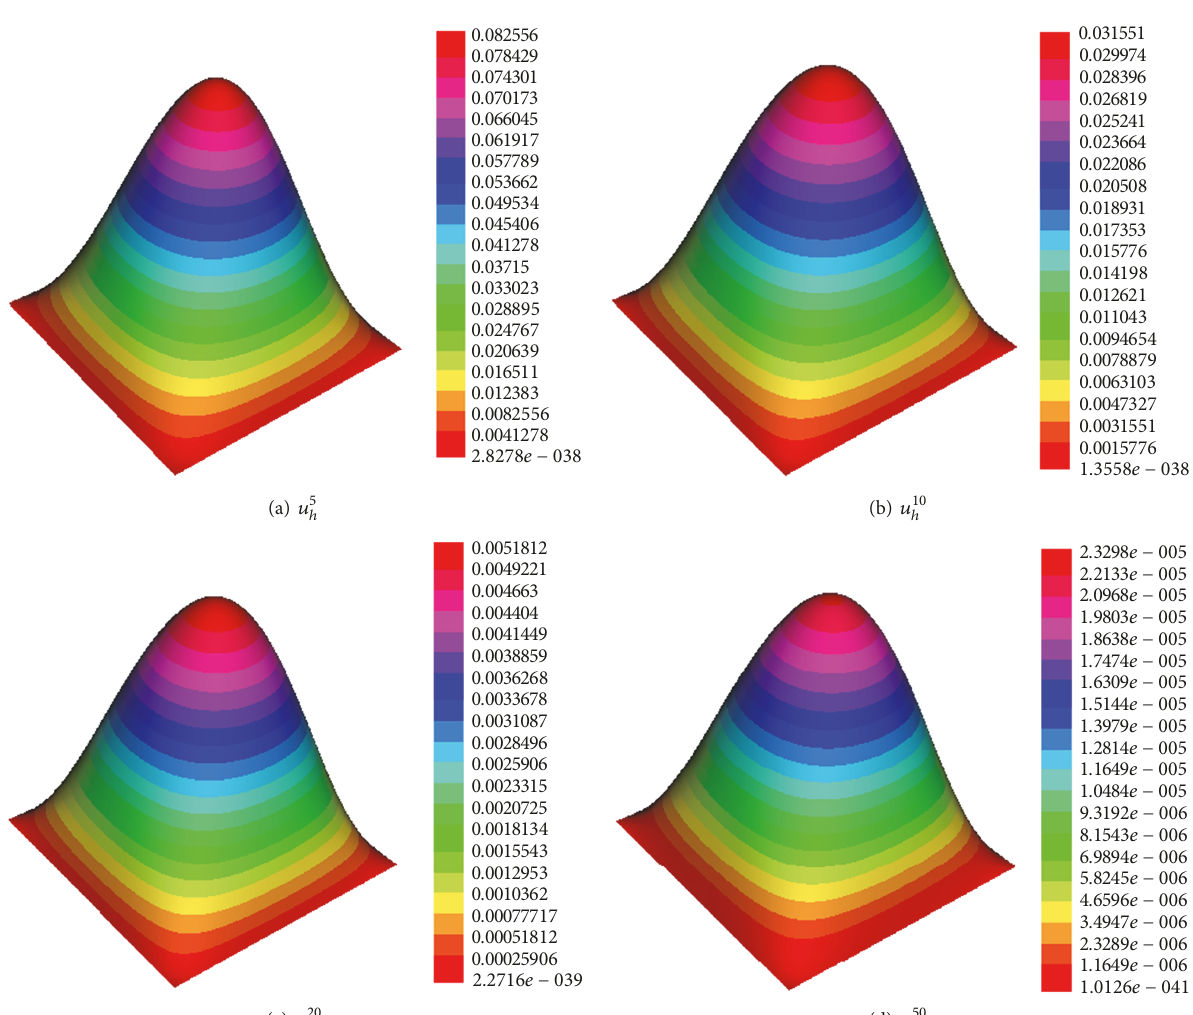
Figure 3: Numerical solutions for Application